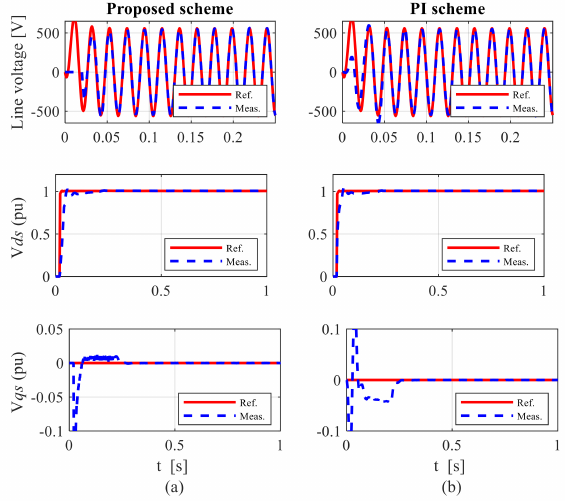
Figure 15. Control performances during sub-synchronous speed operation for f = 48 Hz: ( a ) proposed scheme and ( b ) PI scheme.